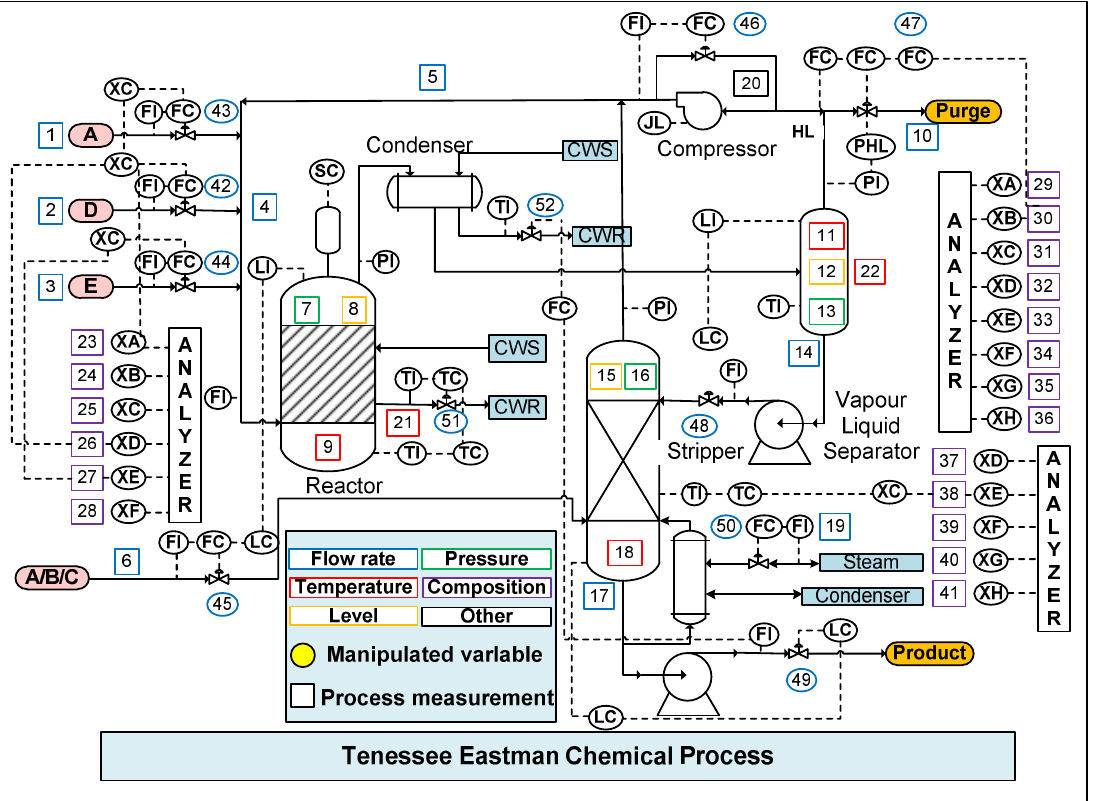
Figure 3. Schematic layout of the Tennessee Eastman chemical process (TECP) [33].